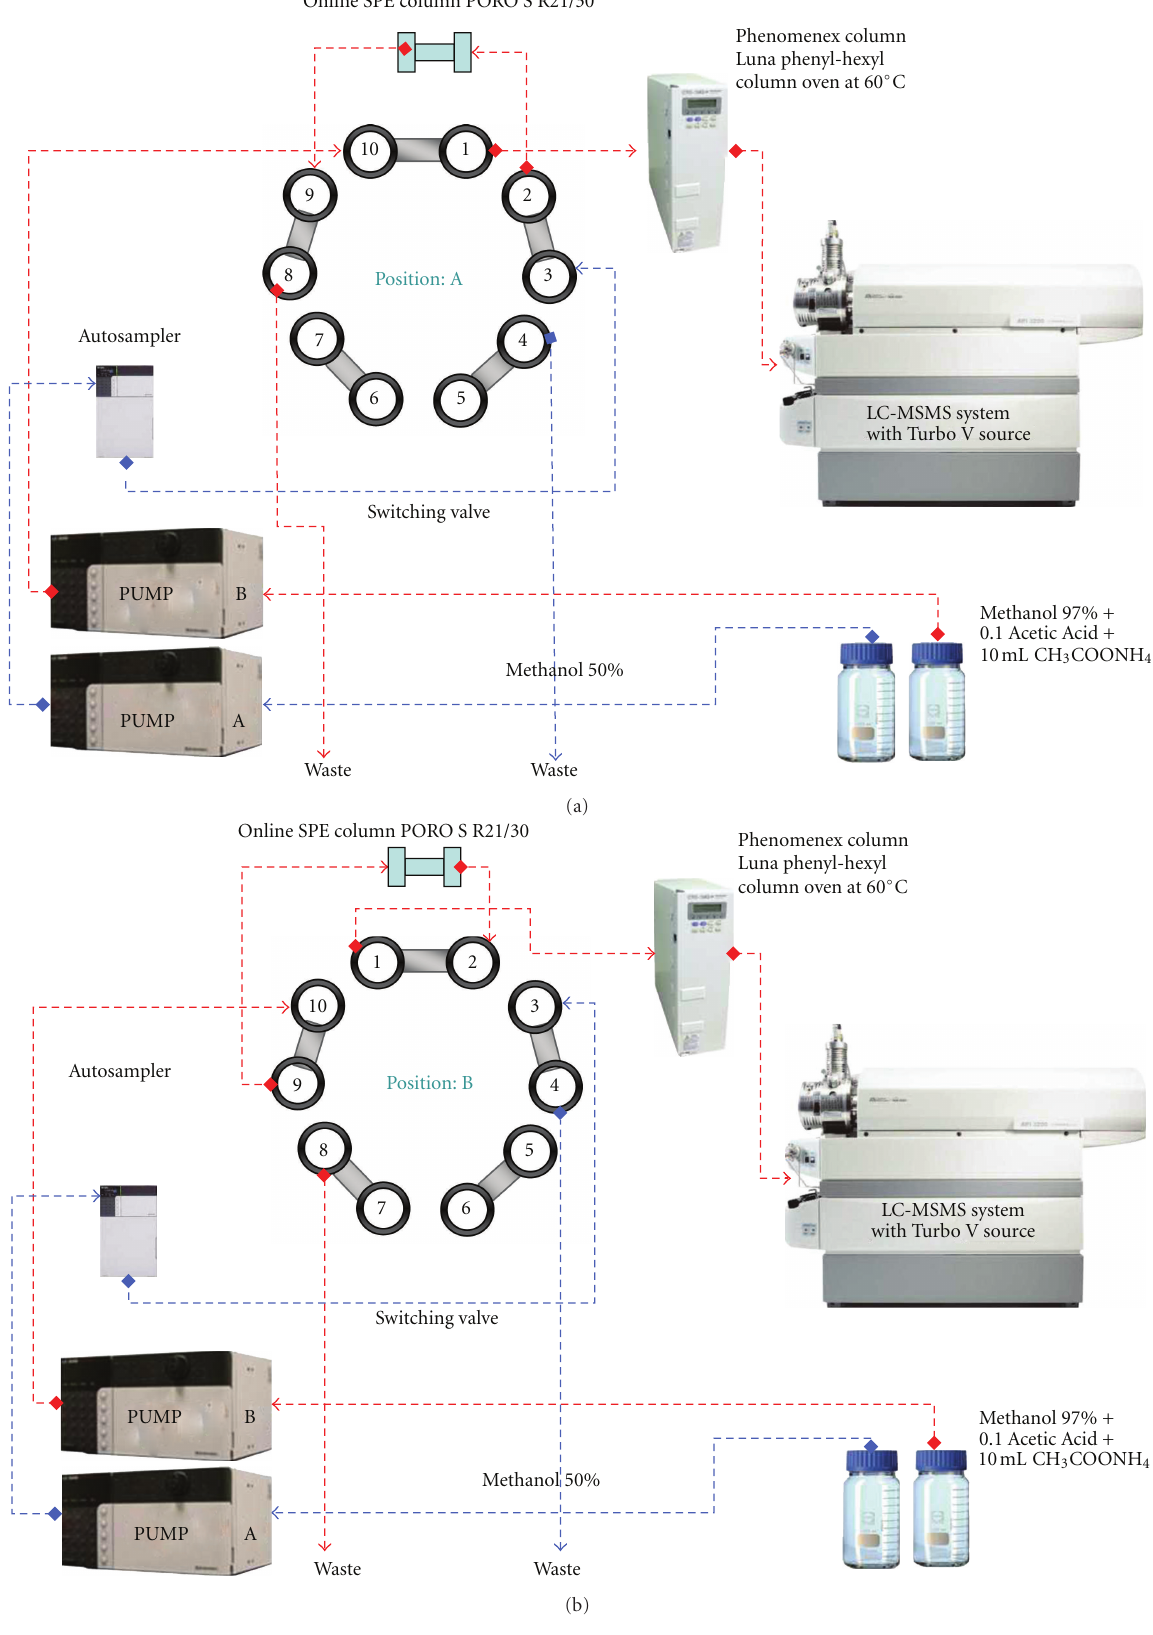
Figure 1: Column switching procedure of the online SPE-LC-MS/MS setup: (a) sample loading and clean-up; (b) sample elution from the analytical